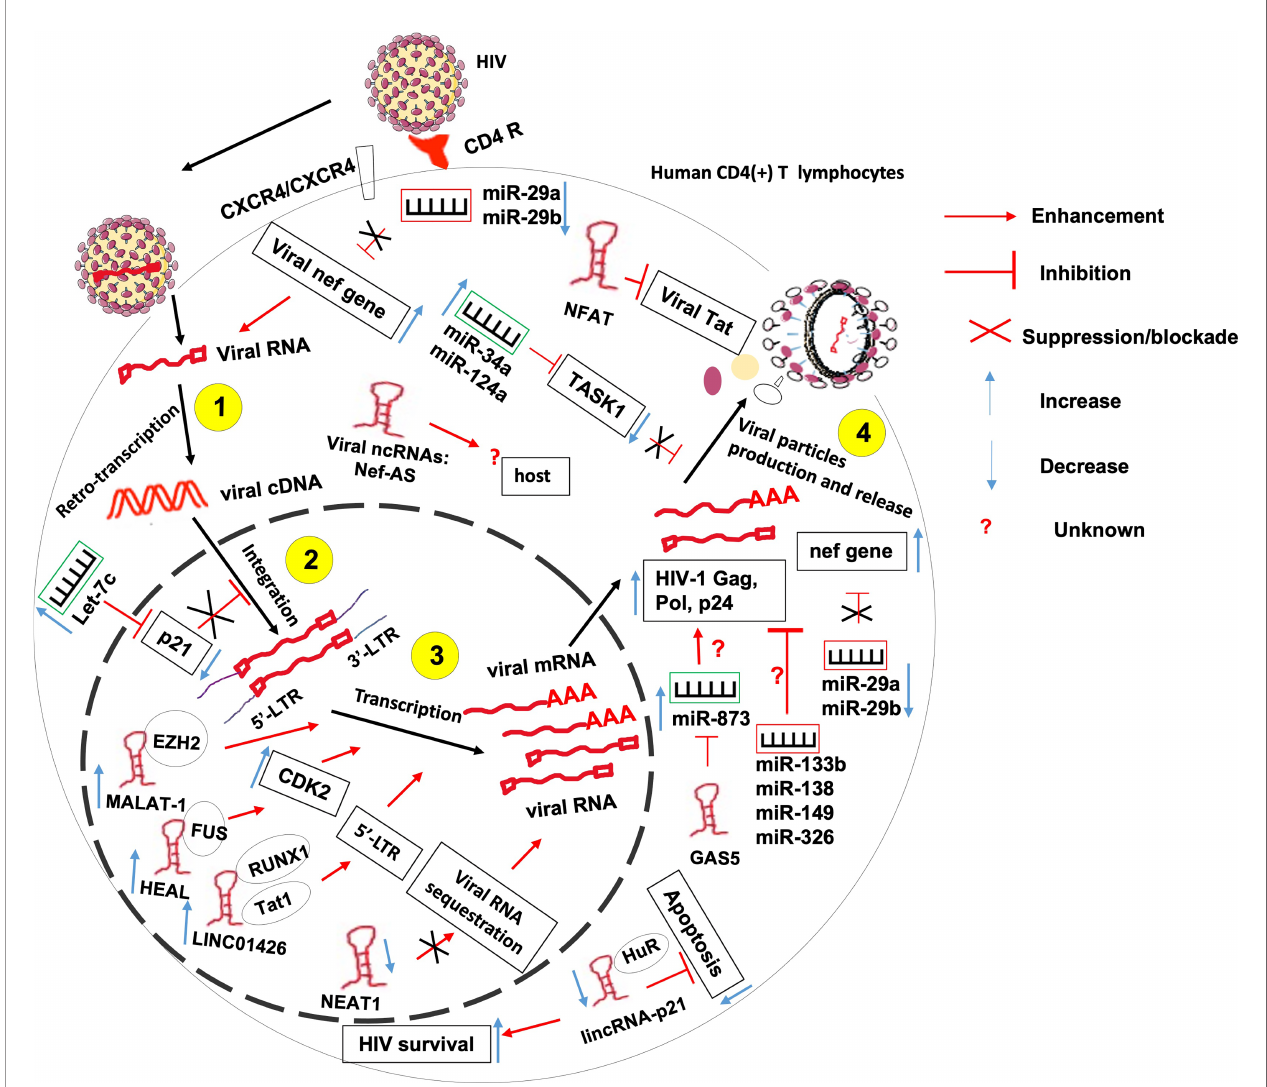
FIGURE 3 | The role of non-coding RNAs in the etiology of HIV/AIDS. ncRNAs control several steps of HIV life cycle including viral RNA retro-transcription, cDNA integration, transcription and viral particles production. More research needed to identify 1- host ncRNAs that regulate viral particles release from the host and 2- the role of HIV-derived ncRNAs on the outcome of HIV-T lymphocyte